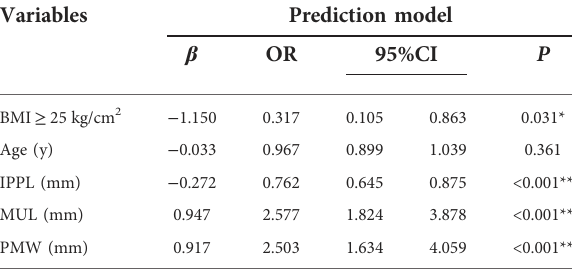
TABLE 2 Prediction factors for the recovery of immediate urinary continence with patients following LRP.